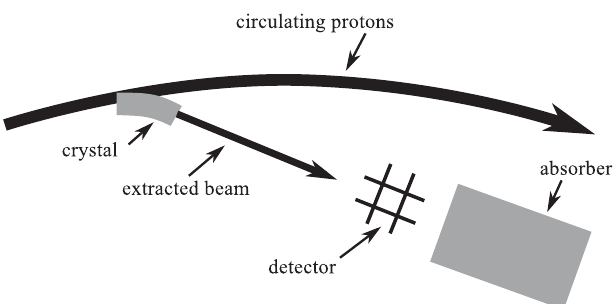
FIG. 2. The experimental setup for the beam extraction and collimation by bent crystals.